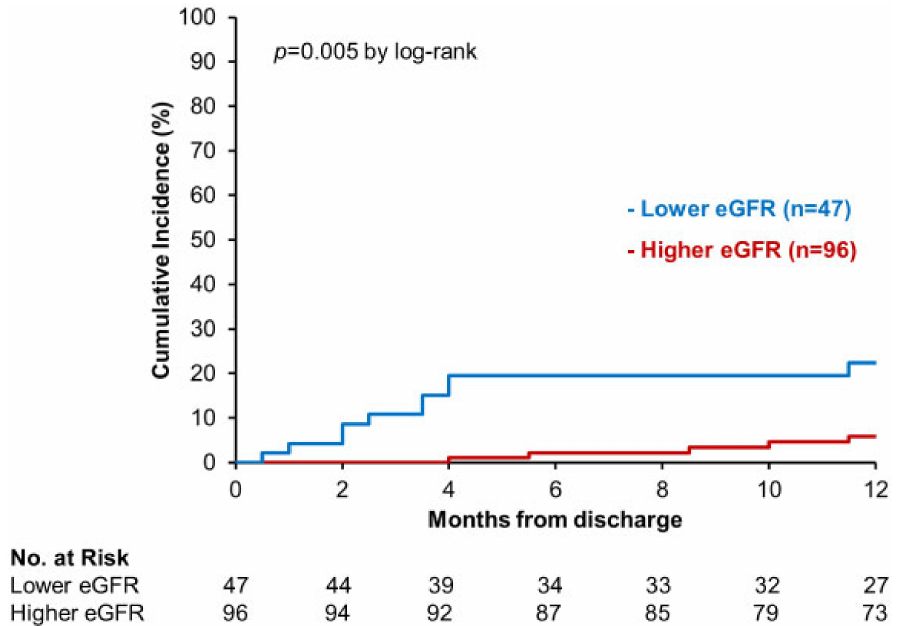
Figure 2. Recurrent hospitalization for heart failure in patients stratified by baseline estimated glomerular filtration rate (eGFR).